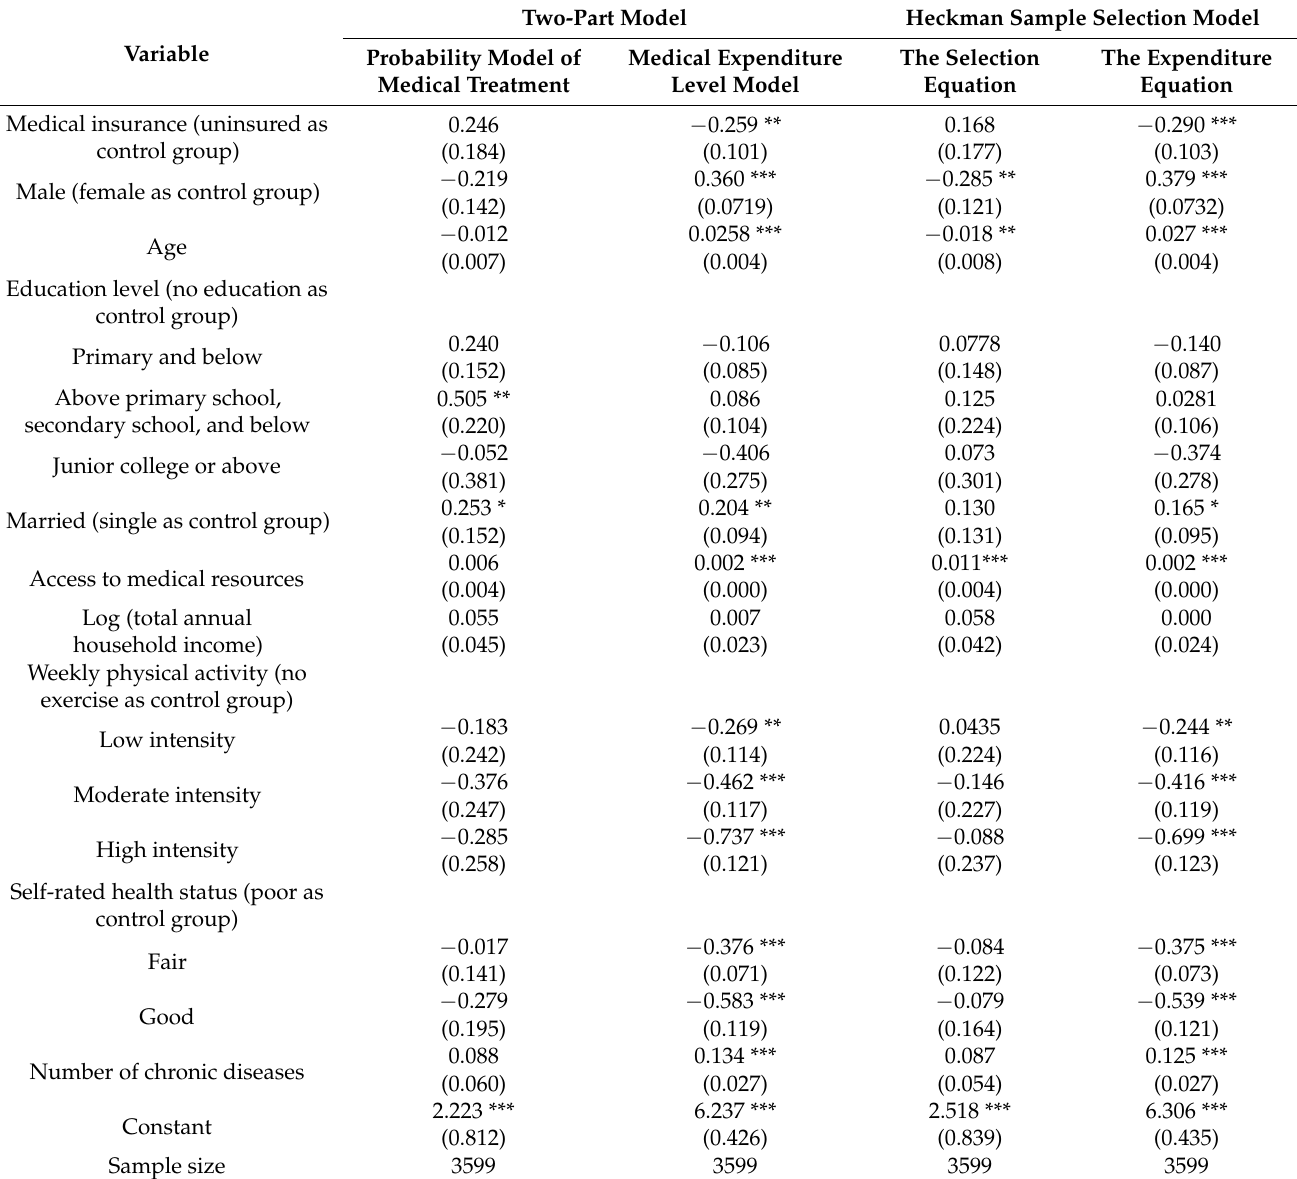
Table 2. The substitution effect of medical insurance on total medical